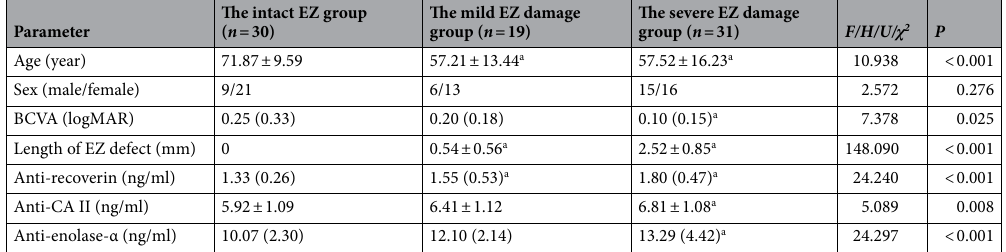
Table 1. Baseline characteristics and levels of ARAs in the aqueous humor in different groups. a P < 0.05 comparing to the intact EZ group.